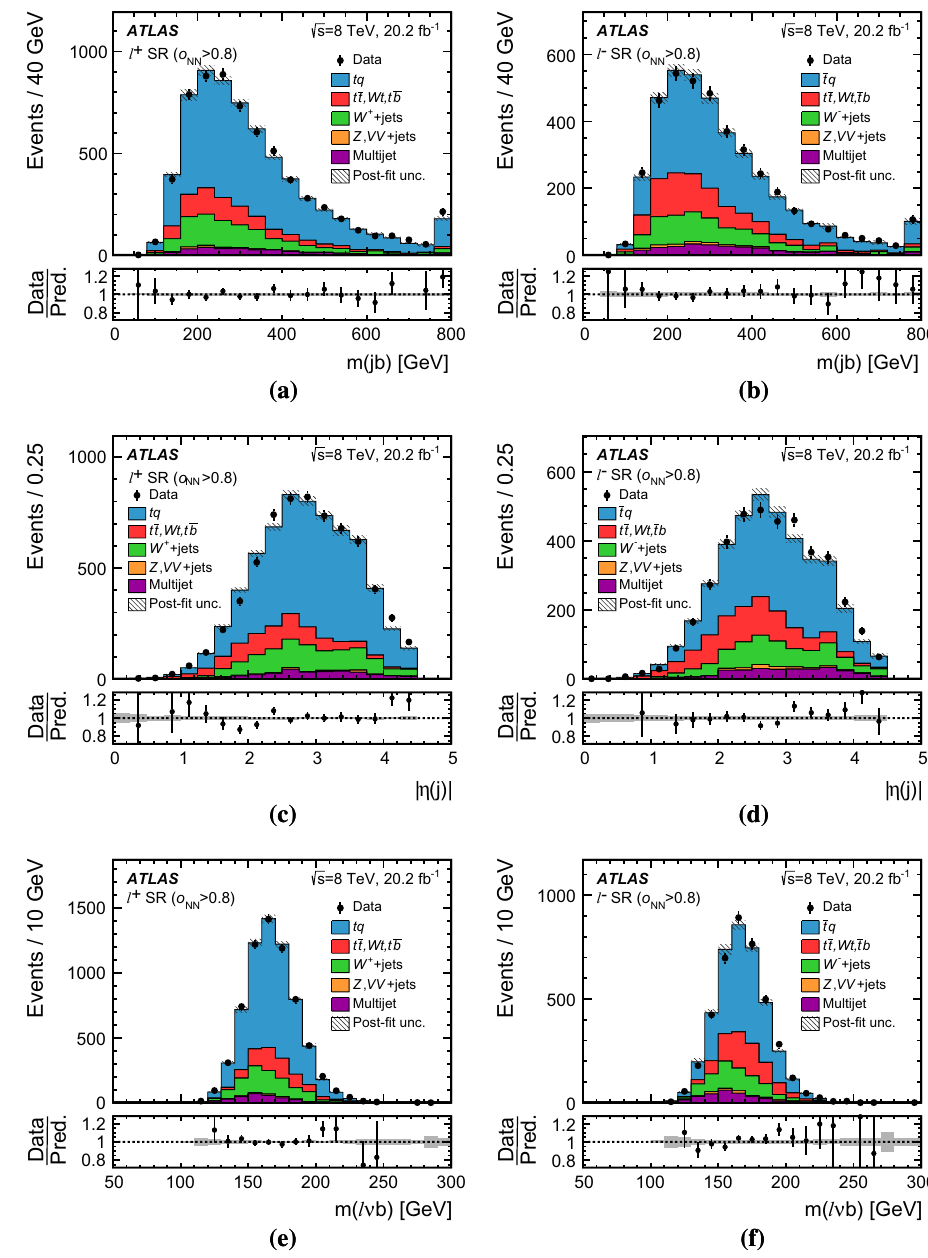
Fig. 12 Observed distributions of the first three input variables to the default neural network in the signal region (SR), after a cut of O NN > 0 . 8 on the network output. The distributions are compared to the model obtained from simulated events. The simulated distributions are normalised to the event rates obtained by the fit to the discriminants. The definitions of the variables can be found in Table 2. The hatched uncertainty band represents the total uncertainty in the rates of all processes after the fit and the bin-by-bin MC statistical uncertainty, added in quadrature Events beyond the x -axis range in a and b are included in the last bin. The lower panels show the ratio of the observed to the expected number of events in each bin to illustrate the